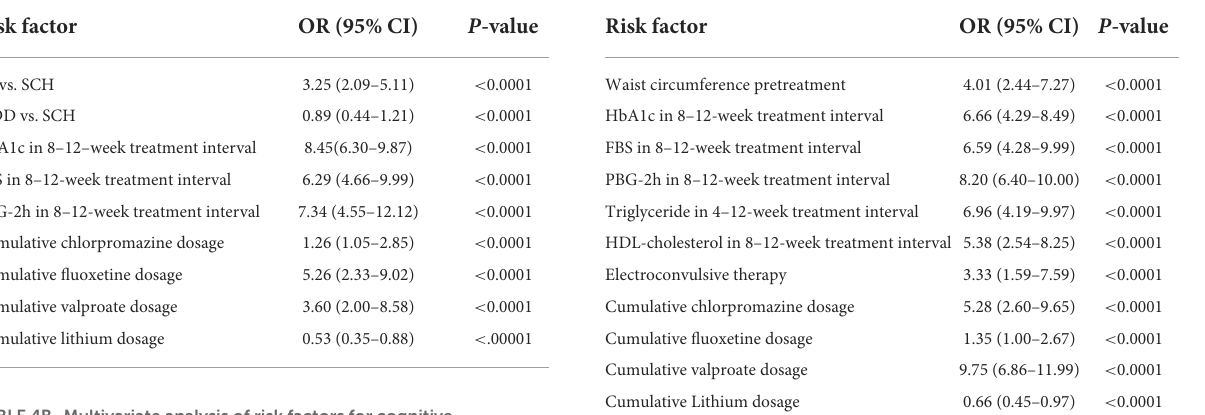
TABLE 4A Multivariate analysis of risk factors for cognitive impairment in all subjects.